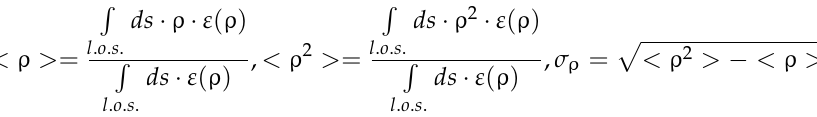
Figure 12. ( a ) Radial resolution without halo effect and with halo effect; ( b ) radial resolution without